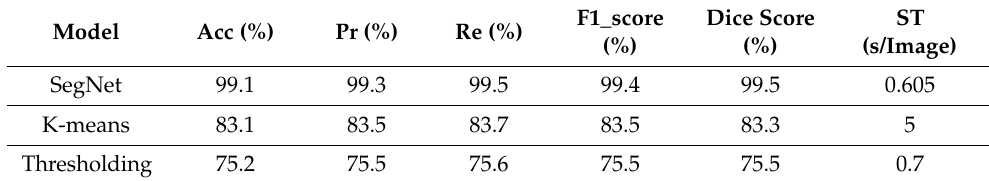
Table 5. The segmentation performance measures (Acc, Pr, Re, F1_score, Dice score, and